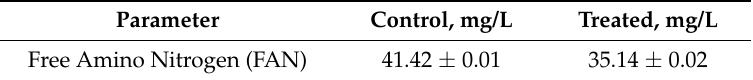
Table 3. Free Amino Nitrogen of the mash.